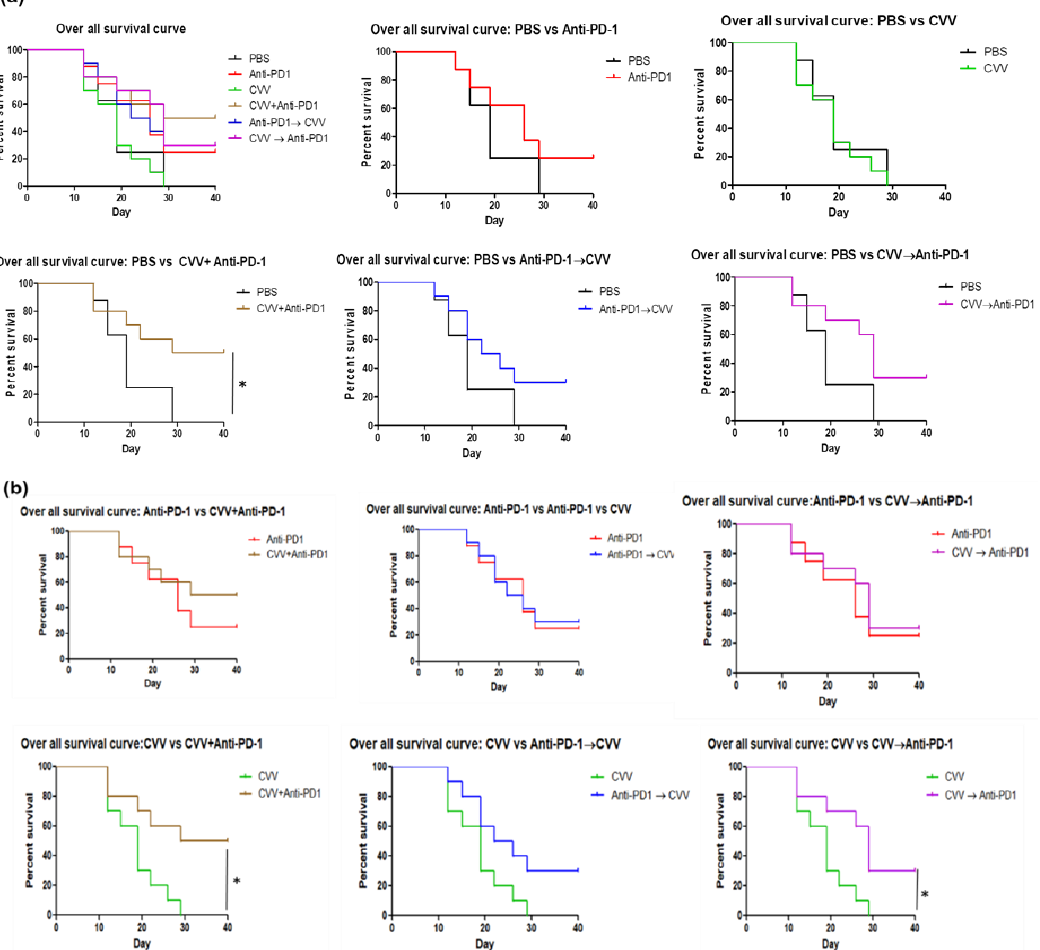
Figure 4. Survival curve analyses. Kaplan–Meier curves were plotted on the basis of tumor volume. Tumor volume > 1000 mm 3 was considered death. ( a ) Overall survival curve. ( b ) Overall survival curve: monotherapy vs. combination therapy. * p < 0.05.